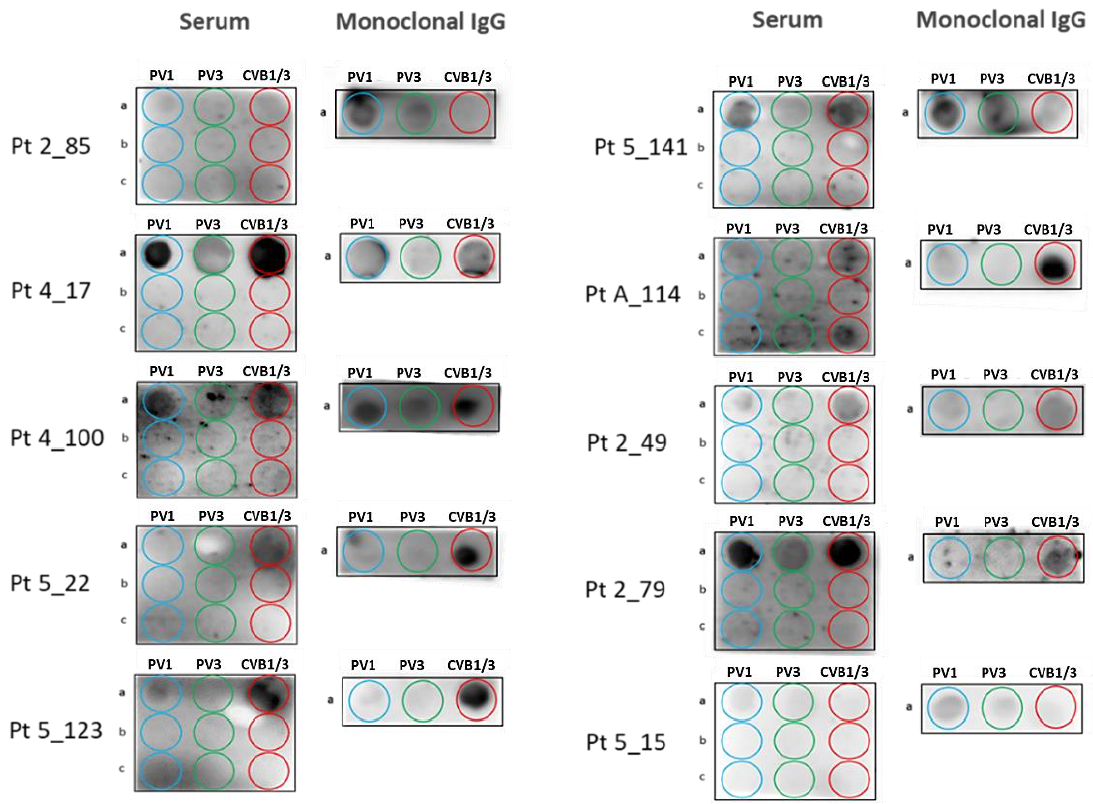
Figure 4. Results of the “PV/CVB” Dot Blotting Assays obtained for the 10 Additional Patients Who Presented a Monoclonal Ig Specific for PV1, PV3 or CVB1/3 Peptides. Membranes were spotted with nine peptides: ( a ) HP-1a, HP-3a and HC-a, respectively relevant to PV1, PV3 and CVB1/B3; ( b ) irrelevant HP-1b, HP-3b and HC-b peptides; ( c ) irrelevant HP-1c, HP-3c and HC-c peptides (see Supplementary Table S2), then incubated with serum (left) or purified monoclonal Ig (right), followed by revelation (see Materials and Methods). After validation that no signal was obtained with irrelevant peptides for serum samples, purified monoclonal Igs were incubated with relevant peptides only. Patients 2_49, 2_79, 5_15 are NDMM; all others are MGUS.